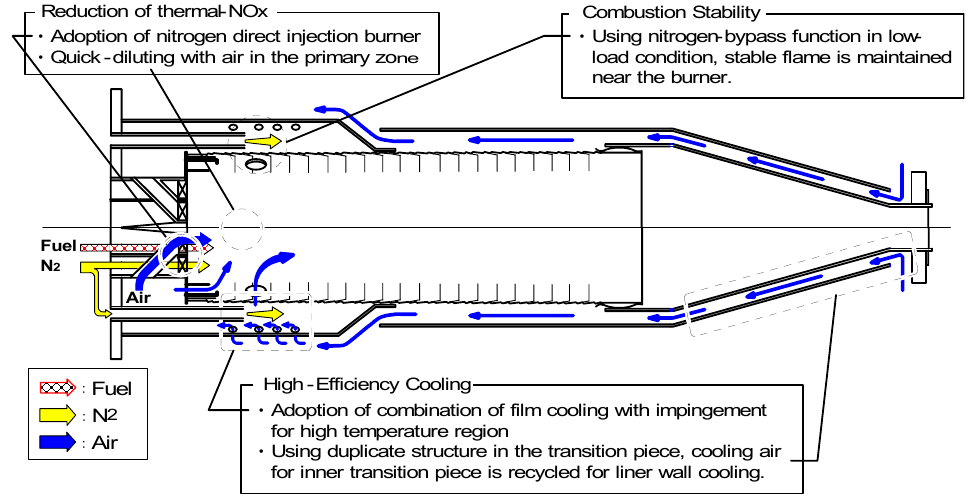
Figure 66. Design concept of medium-Btu fueled combustor for wet-type synthetic gas